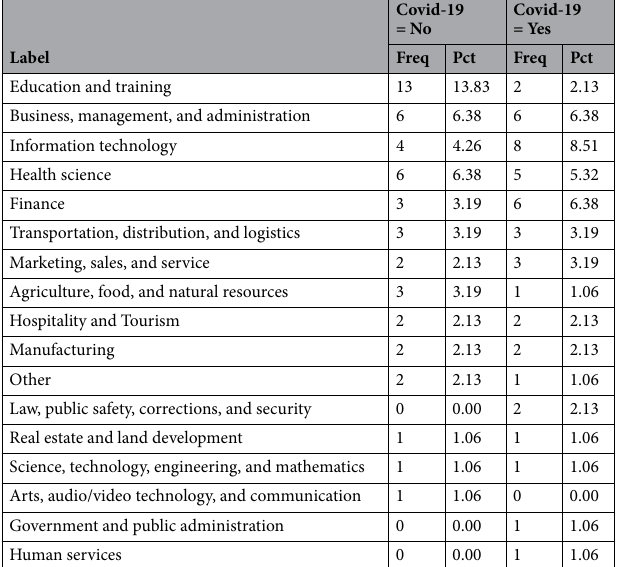
Table 1. Number of participants per employment sector.